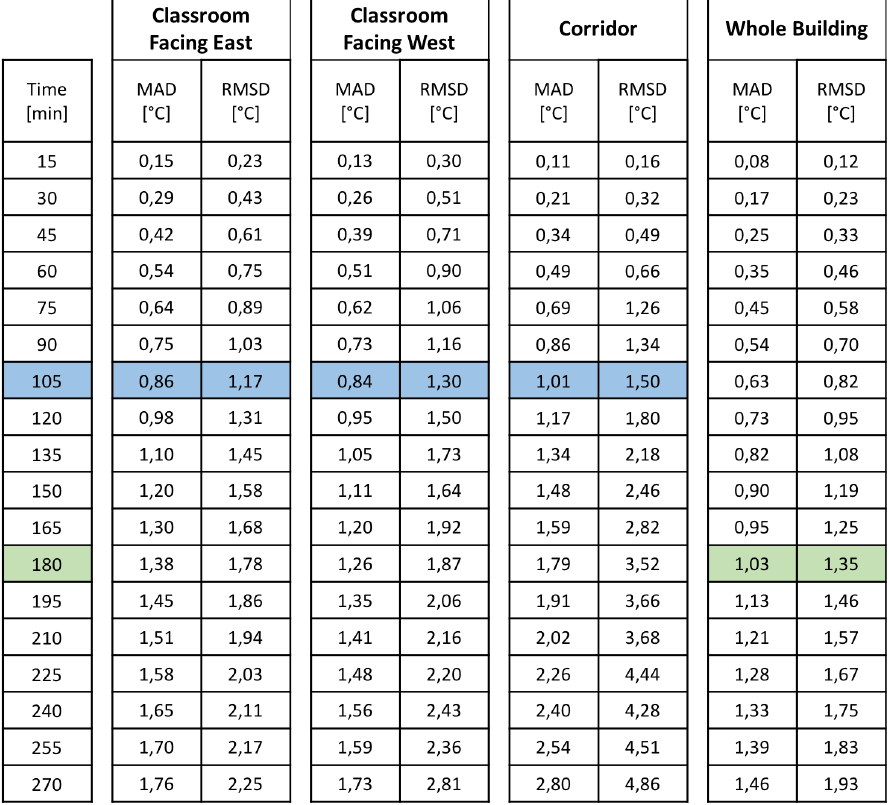
Figure 6. Prediction performance on the real-measurements dataset. Blue and green lines correspond to the maximum prediction horizons that guarantee acceptable thermal comfort, respectively for the individual rooms and the whole building